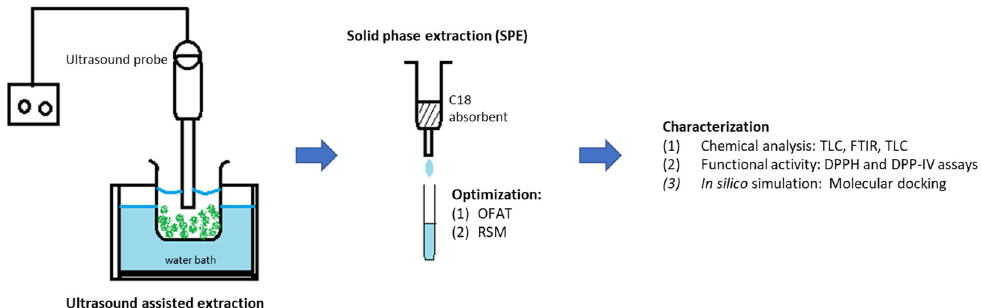
Figure 2. Schematic diagram of the experimental works .